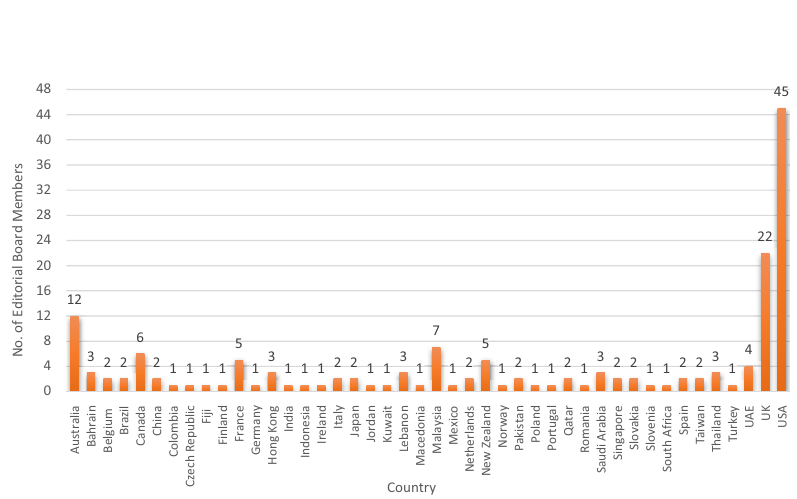
Figure 2. Editorial members country-wise